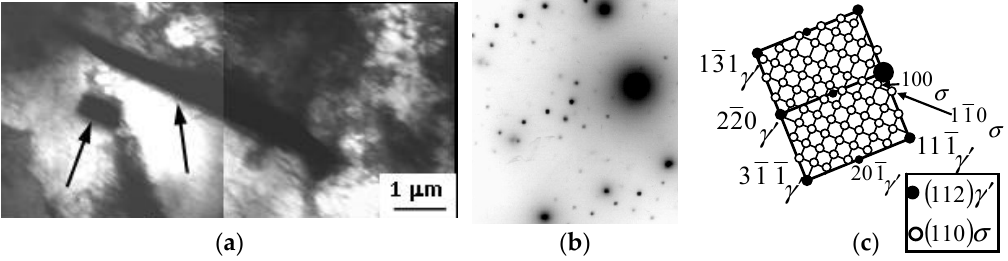
Figure 7. Electron microscopic image of the structural phase state “ В ′ ” in the alloy after DC and subsequent annealing: ( a ) bright-field image (arrows indicate particles of the σ -phase); ( b ) microdiffraction pattern; ( c ) its diagram.